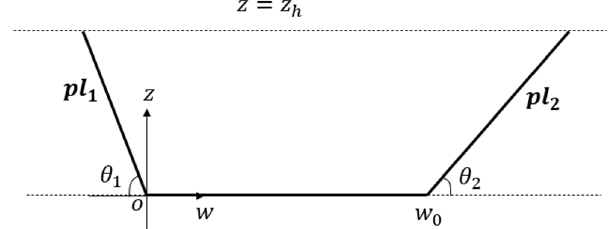
) respectively and penetrate into the bulk with angles θ 0